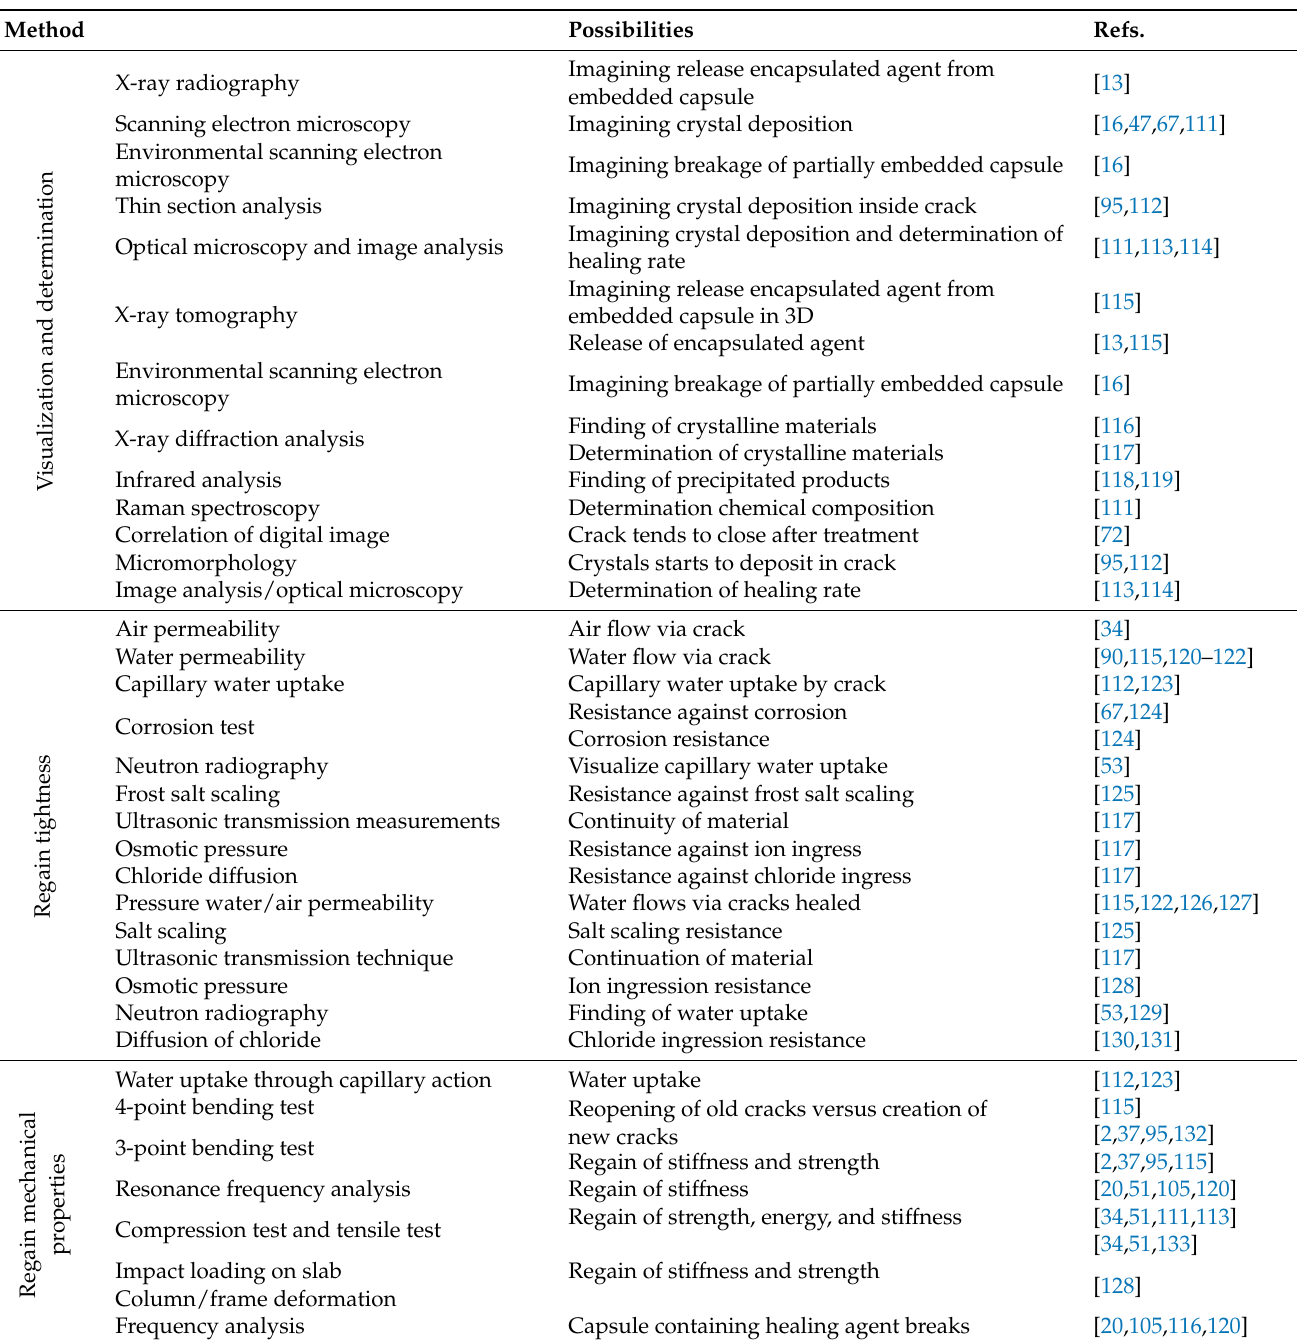
Table 2. Methods used to evaluate the crack’s healing